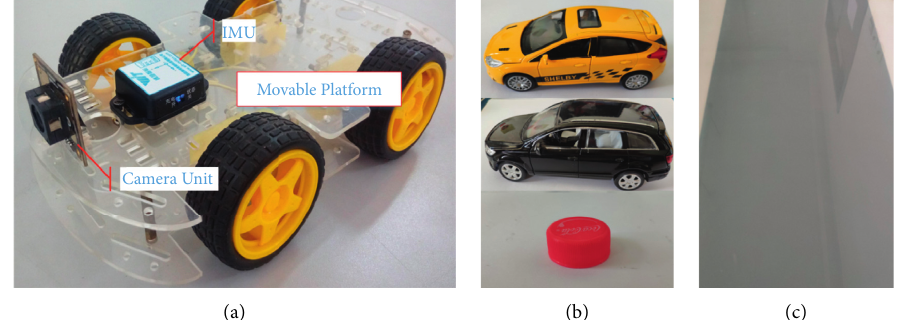
Figure 16: Experimental equipment. (a) Mobile platform, camera unit, IMU. (b) Vehicle scaled model (known obstacle) and unknown obstacle model. (c) Polished paper simulates reflection road.